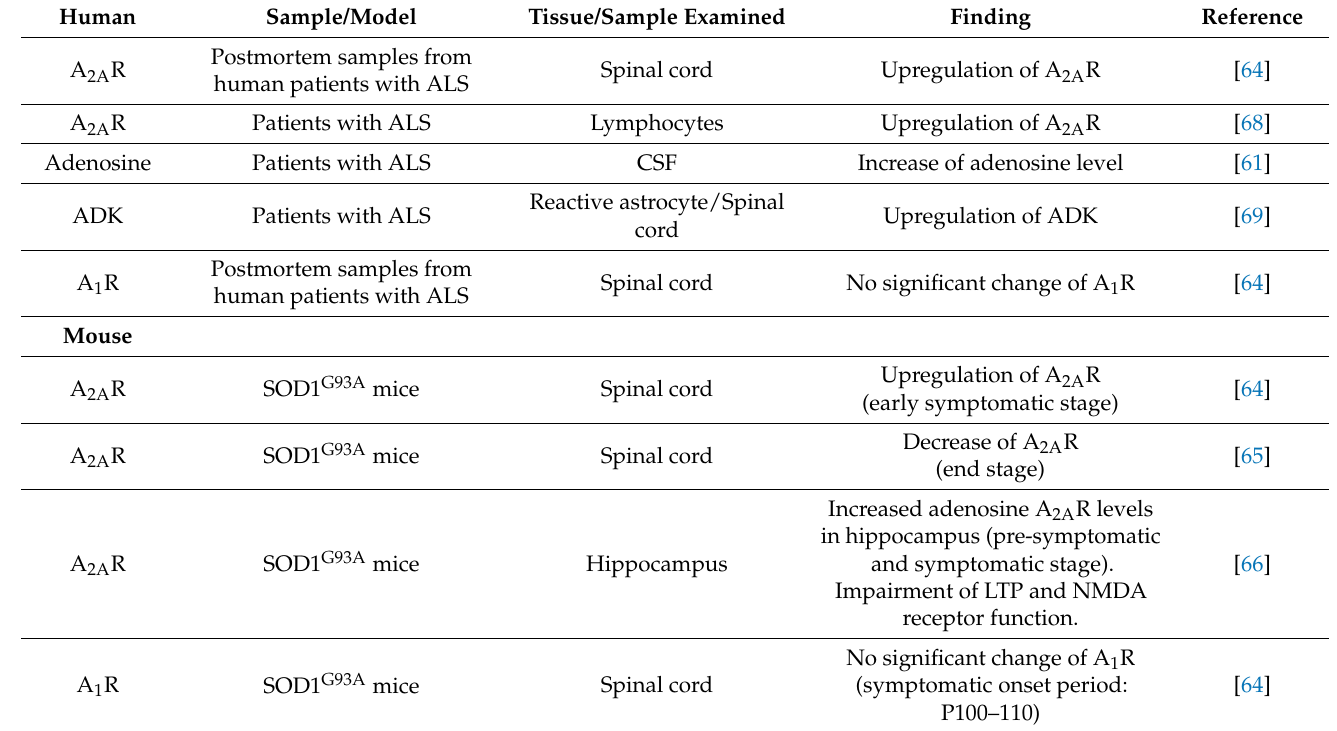
Table 2. Alteration of adenosine and adenosine receptors in ALS and models.